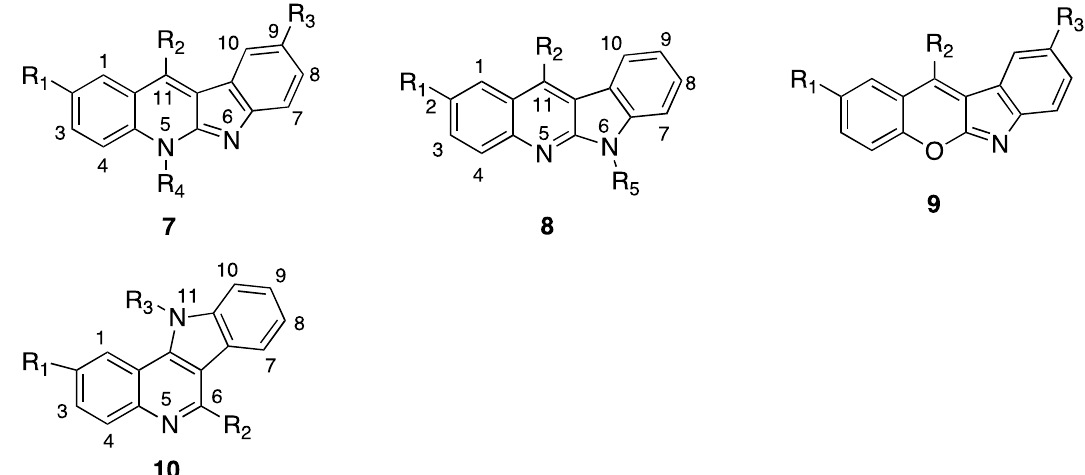
Figure 3. Structure of neocryptolepine derivatives 7 , 8 , chromeno[2,3- b ]indoles 9 , and isocryptolepine derivatives 10 .